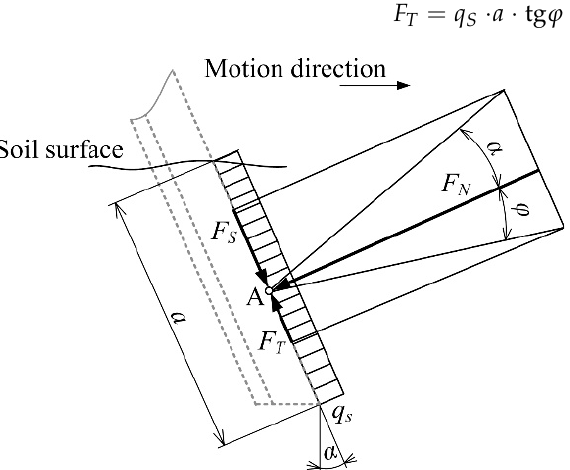
Figure 3. Determination of cutting blade inclination angle: F N —normal force; F T —frictional (tan- gential) force; F S —sinkage force; q s —specific load; α —cutting blade inclination angle; ϕ —frictional angle; a —contact length of cutting blade with soil; A—point of action.